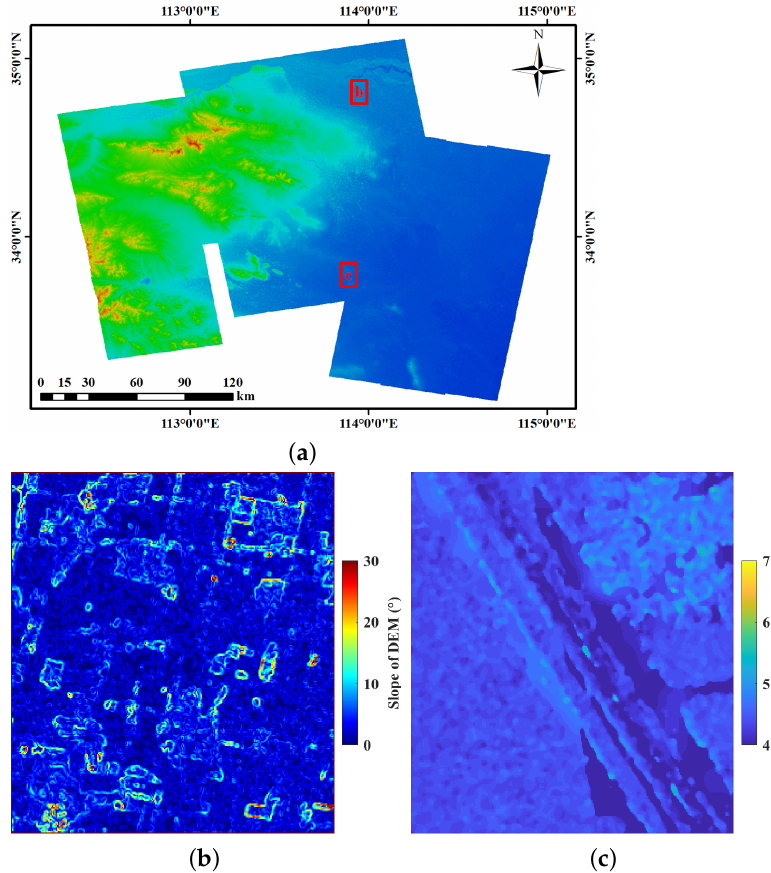
Figure 14. The mosaic rendering map of twenty-nine scenes DEM data after adjustment. ( b , c ) are the slope map and enlarged view of the corresponding marked areas in ( a ).